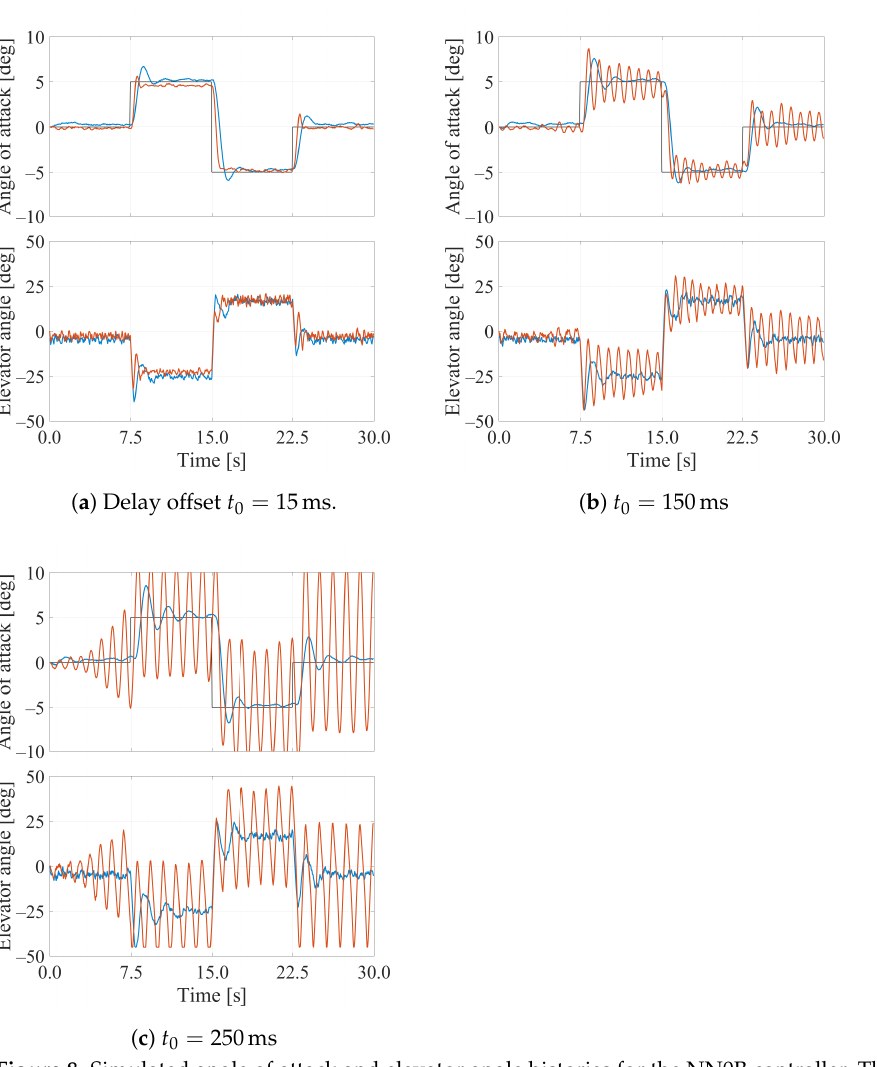
Figure 8. Simulated angle of attack and elevator angle histories for the NN0B controller. The doublet angle-of-attack schedules were plotted with black lines. Wind speeds were 10m/s (blue lines) and 20m/s (orange lines). Applied time delay was t 0 = 15ms ( a ), 150ms ( b ) and 250ms ( c